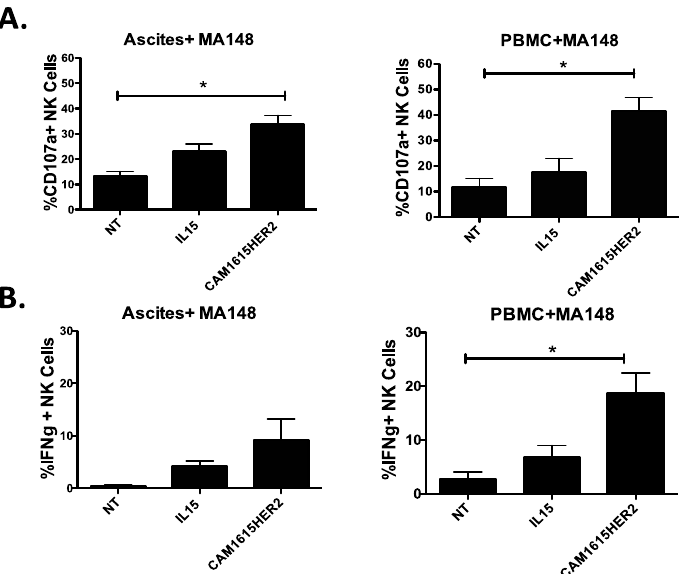
Figure 5. CAM1615HER2 TriKE can activate ovarian cancer patient NK cells. To evaluate the ability of the CAM1615HER2 TriKE to induce activity on NK cells from the relevant tumor microenvironment, ascites (left column) was obtained from high-grade ovarian cancer patients at the time of surgical debulking and compared to PBMCs (right column) from normal donors. Cells were incubated with MA148 ovarian cancer cells and noted treatments (at 30 nM) for 5 h and surface CD107a expression ( A ) and intracellular IFN γ expression ( B ) were evaluated on NK cells by flow cytometry ( n = 9). Error bars display mean ± SEM, and statistical significance was shown as * p < 0.05.